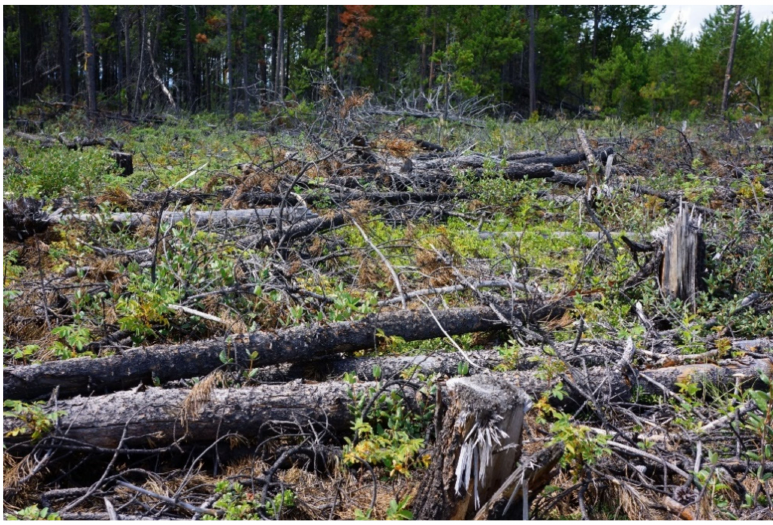
Figure 6. Untreated (elevated) slash two years after